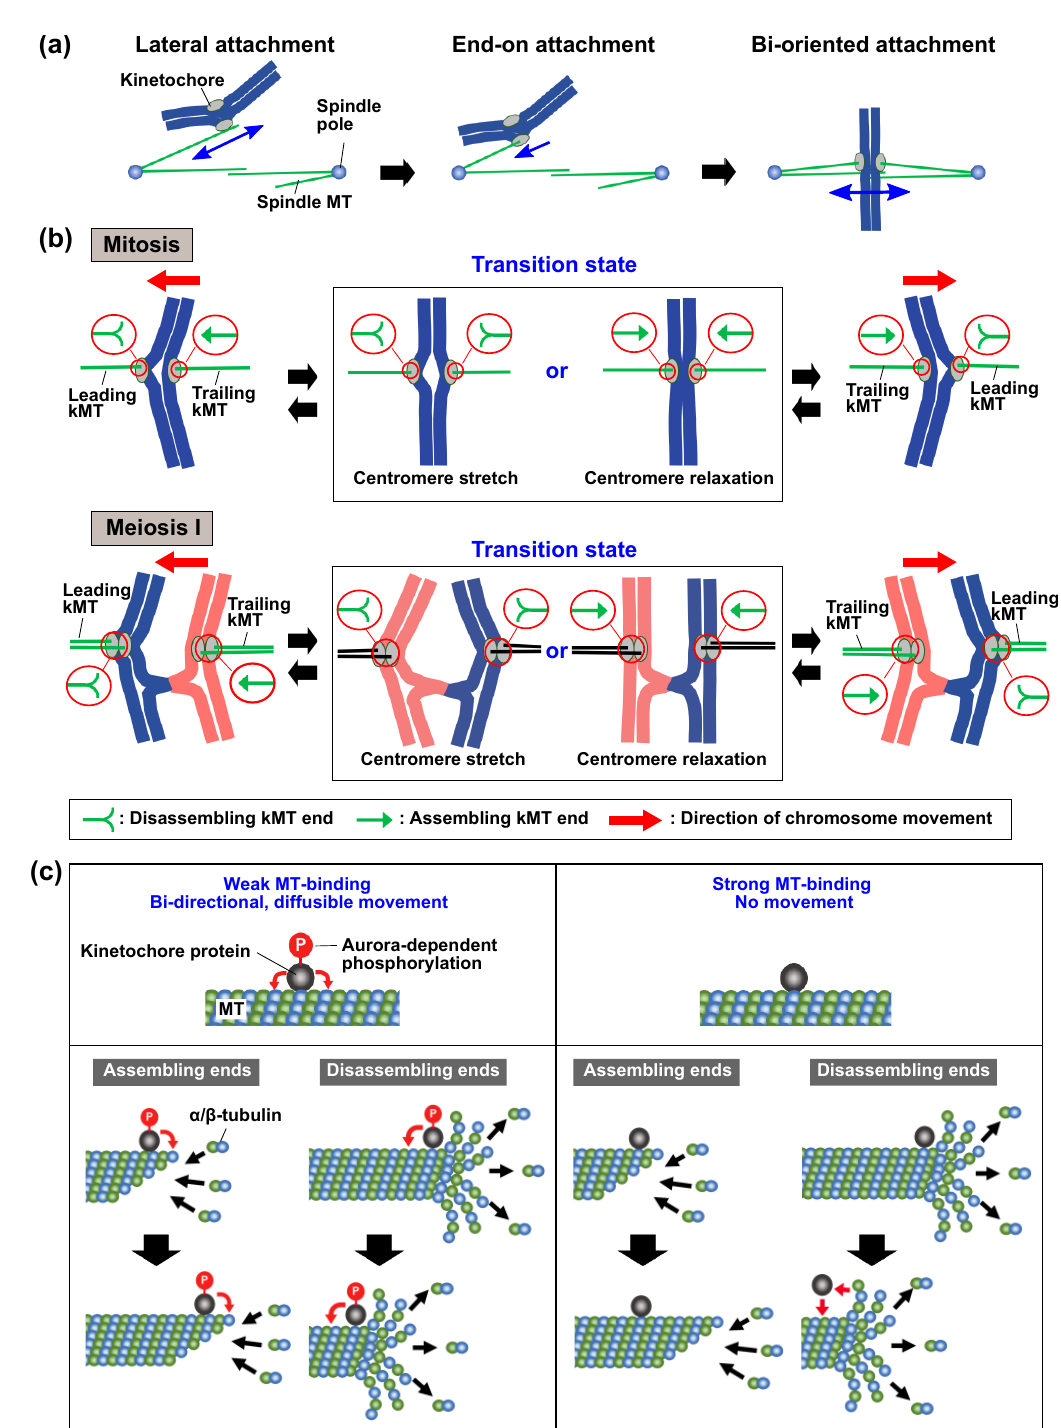
Figure 3. The process of attachment establishment and the mechanism of oscillation of bi-oriented chromosomes. ( a ) The process of chromosome attachment to the spindle in mitosis. Sister chromatids initially interact laterally with MTs extending from the spindle pole (spindle MT) and repeat poleward and anti-poleward movements (lateral attachment). MT shortening promotes the interaction of the kinetochore with the end of the MT (end-on attachment). After end-on attachment of one kinetochore, the other kinetochore interacts with MTs extending from the other pole, resulting in bi-oriented attachment of sister chromatids (bi-oriented attachment). Blue arrows show movement of chromosomes. ( b ) MT dynamics and oscillation of bi-oriented chromosomes in mitosis and meiosis I. During poleward movements of bi-oriented chromosomes, kinetochore-interacting MTs (kMTs) that extend forward of moving chromosomes (leading kMTs) undergo disassembly